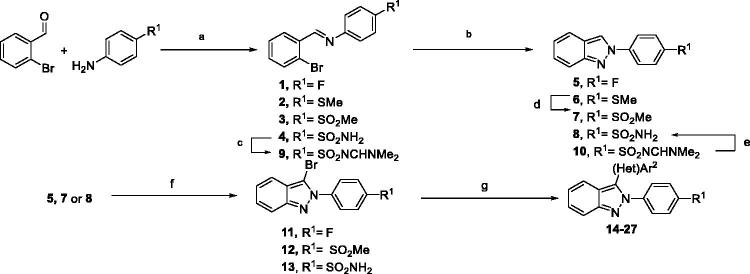
Synthesis of di(het)arylated indazoles 14–27. Reagents and conditions: (a) 2- bromobenzaldehyde (1.0 equiv), aniline (1.01 equiv), MgSO4 (5.0 equiv), THF, 100 °C, μW, 1: 10 min, 99%; 2: 15 min, 99%; 3: 1.5 h, 95%; 4: 1.5 h, 90%; (b) NaN3 (2.5 equiv), CuI (0.1 equiv), DMSO, 150 °C, μW, 5 min, 5: 99%; 6: 99%; 7: 17%; 10: quant TLC; (c) DMF.DMA (2.0 equiv), THF, r.t., 1 h, 98%; (d) Oxone (2.1 equiv), MeOH/H2O (2/1), r.t., 20 h, 83%; (e) NaOH (3.0 equiv), 150 °C, μW, 5 min then HCl conc., 85% from 9; (f) Br2 (1.0 equiv), AcOH/MeOH/CH2Cl2 (2/1/0.1), r.t., 4 h, 11: 95%; 12: 99%; 13: 92%; (g) (Het)Ar2-B(OH)2 (1.2 equiv.), Cs2CO3 (3.0 equiv), Pd(PPh3)4 (0.1 equiv), dioxane, 150 °C, μW, 1 h, structures and yields are indicated in Table 2.